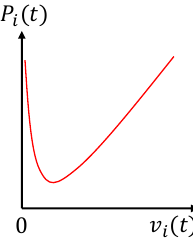
Figure 3. Illustration of the relationship between P i ( t ) and v i ( t )